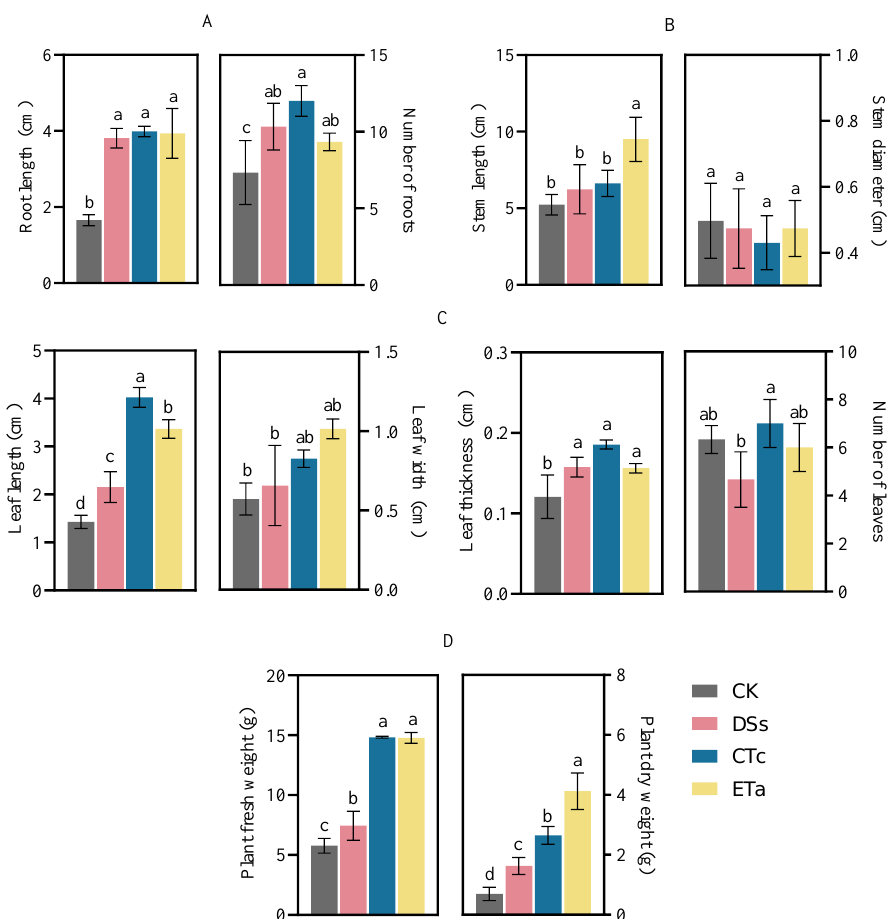
Figure 4. Growth of D. officinale after establishment of symbiosis with different fungi. ( A ) The average root length and root number of the four groups CK, DSs, CTc and ETa. ( B ) The average stem thickness and stem length of each group. ( C ) The average leaf length, leaf width, leaf thickness and leaves of each group. ( D ) The fresh weight and dry weight of the whole plant of each group. Different lowercase letters are significantly different ( p < 0.05) based on Tukey tests.